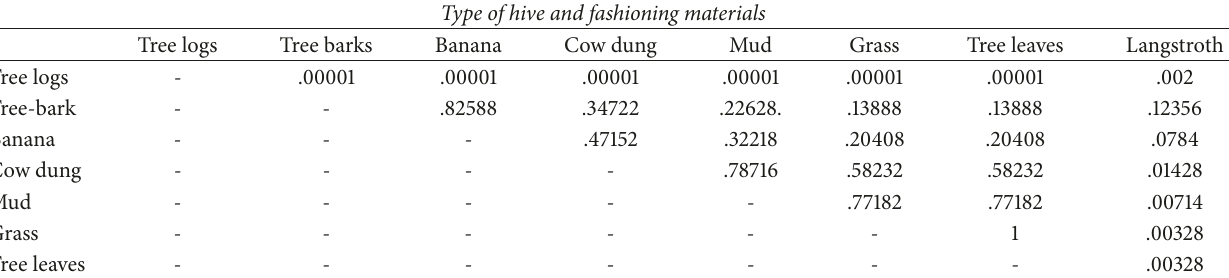
Table 2: P-value matrix for cross tabulation of proportional use of hive-fashioning materials by respondents.